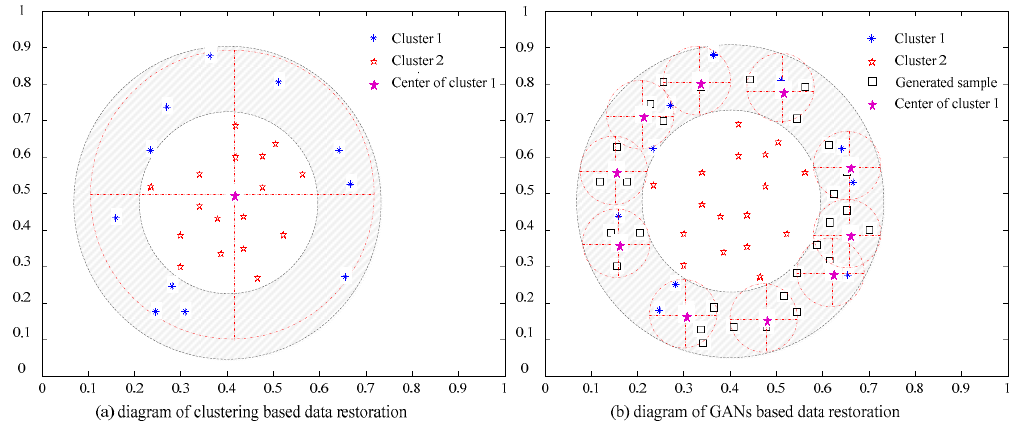
Figure 3. Diagram of comparative performance of data restoration.